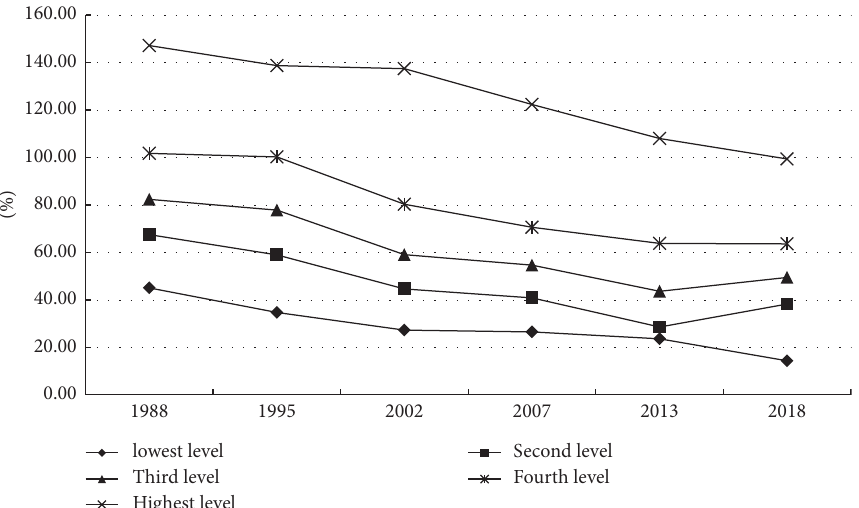
Figure 2: Pension security level of different income level.